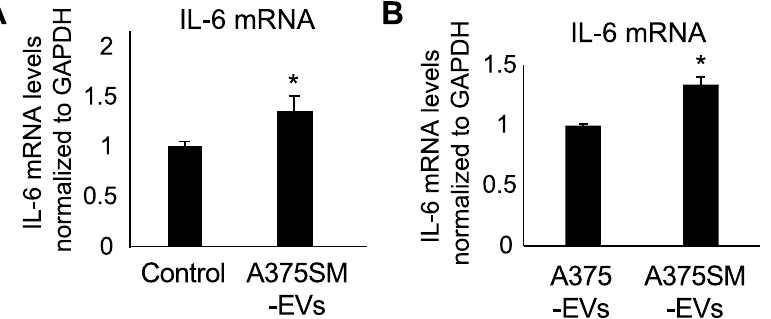
Figure 2. Tumor EVs induces IL-6 mRNA expression. ( A ) IL-6 expression in HMVECs was evaluated through real-time PCR after treatment of HMVECs-derived EVs (Control) or A375SM-derived EVs (A375SM-EVs), respectively, for 24 h (* P < 0.01 vs. Control, two-sided Student’s t -test; data are mean ± SD, n = 4 real-time RT-PCR runs). ( B ) IL-6 expression in HMVECs was evaluated through real-time PCR after treatment of each EV for 24 h (* P < 0.01 vs. A375-EVs, two-sided Student’s t -test; data are presented as mean ± SD, n = 4 real-time RT-PCR